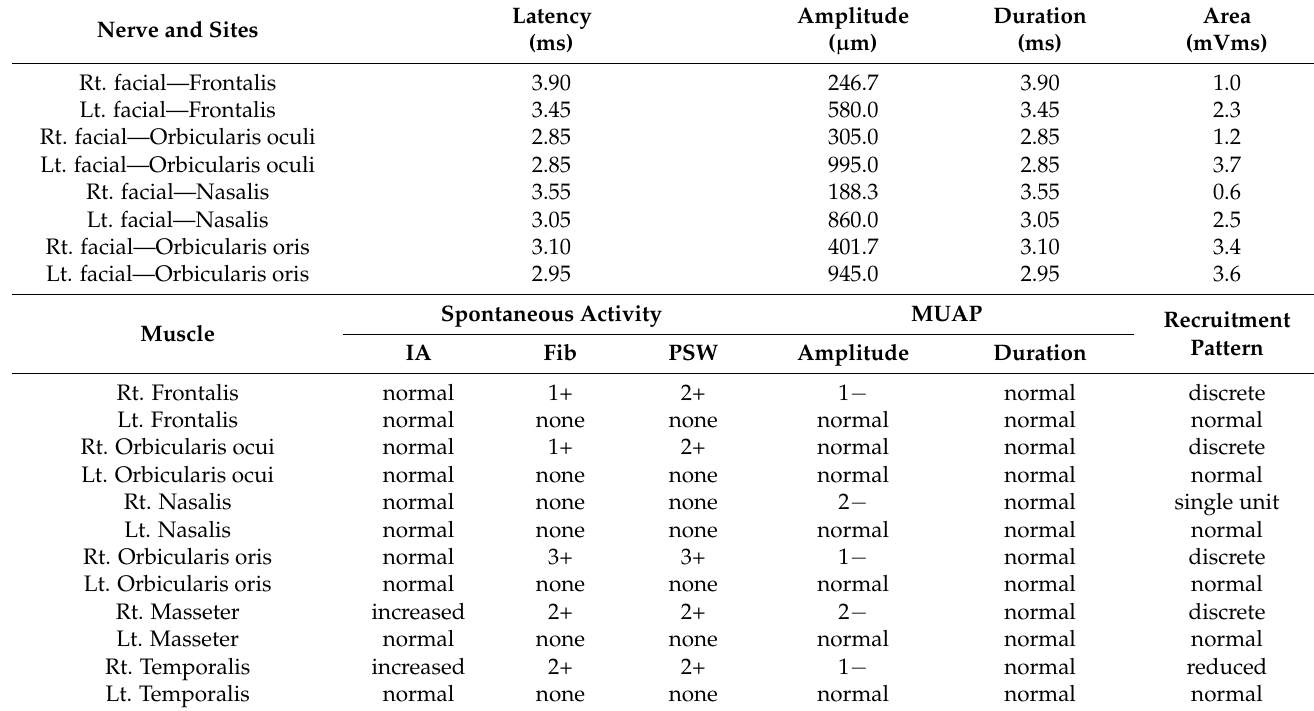
Table 1. Results of the facial nerve conduction study and the needle EMG examination of the present patient.